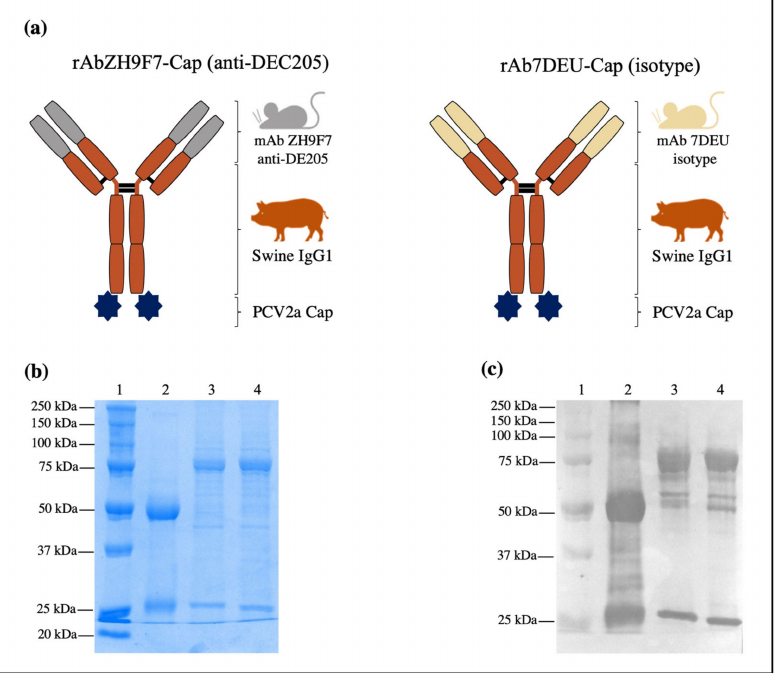
Figure 1. Design, expression, and characterization of rAb ZH9F7-Cap and isotype control